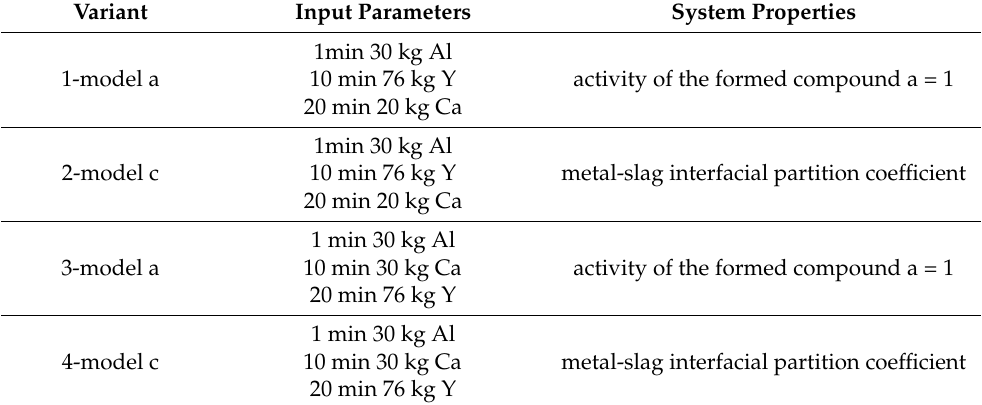
Table 2. Variants of the models and calculations using the WYK_STAL computer program.